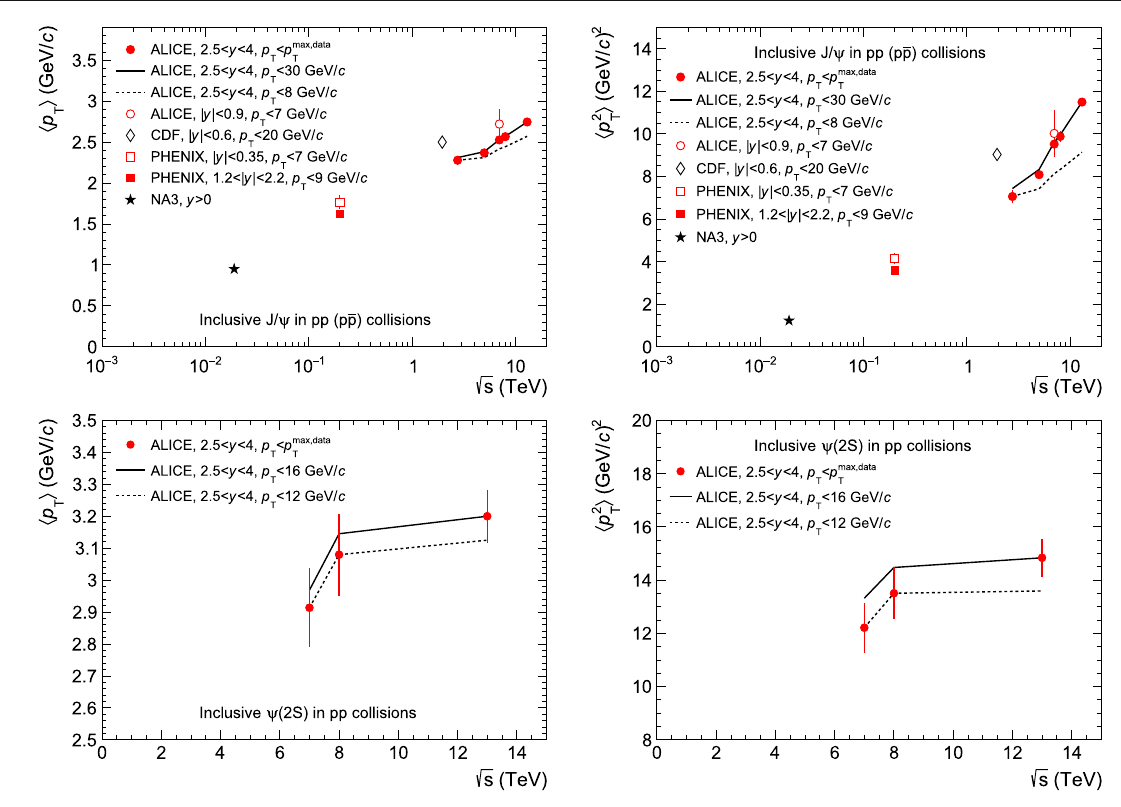
Fig. 6 J /ψ ( left ) and ψ( 2S ) ( right ) inclusive cross section d σ/ d y as a function of statistical and uncorrelated systematic uncertainties. J /ψ cross sections are compared to a CEM calculation from [34]